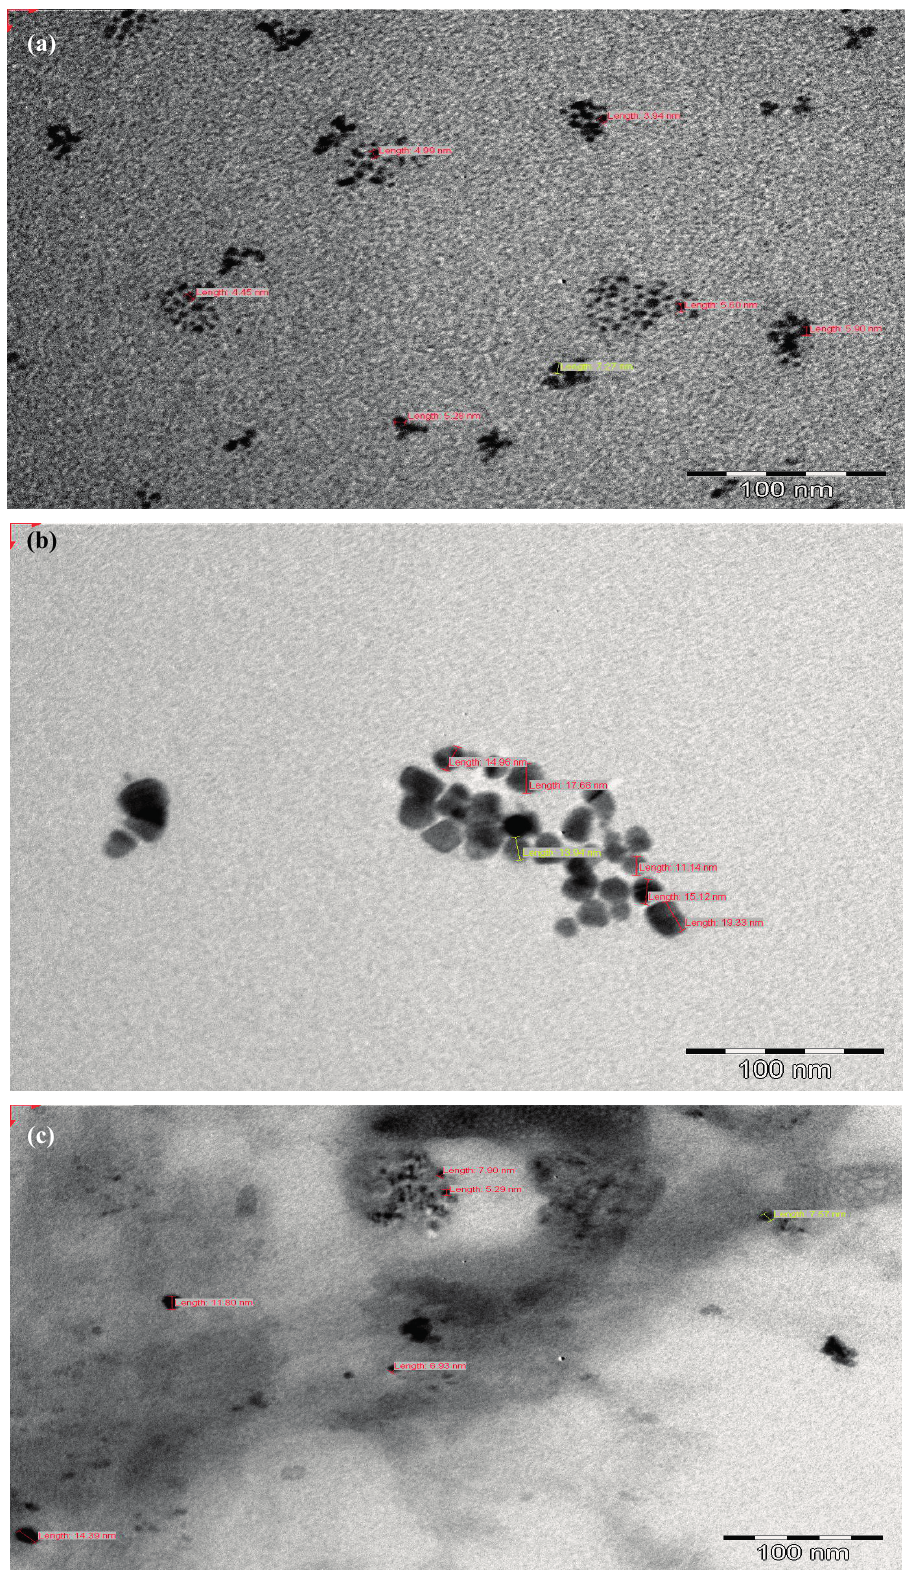
Figure 5. TEM micrographs for ZnS/PMMA ( a ); CdS/PMMA ( b ) and HgS/PMMA ( c